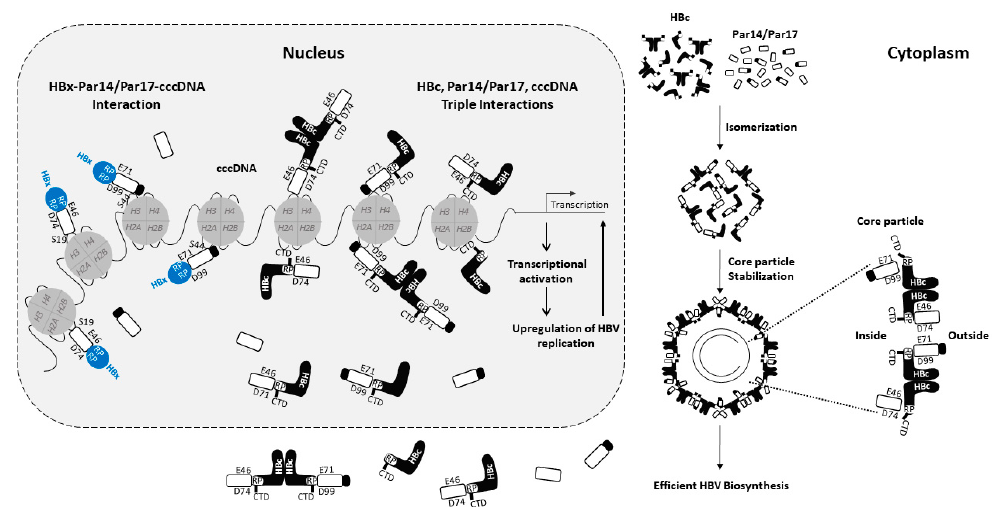
Figure 2. Par14 and Par17 upregulate HBV RNA transcription and DNA synthesis, thereby increasing the HBV cccDNA level. The HBV cccDNA minichromosome is associated with histone and non-histone cellular and viral proteins, including HBc and HBx. The HBx–Par14/Par17–cccDNA complex in the nucleus upregulates HBV RNA transcription, eventually stimulating multiple steps of HBV replication. HBc binds to cccDNA and Par14/Par17 through its C-terminal domain (CTD) and RP motif, respectively. Triple interactions between Par14/Par17, HBc, and cccDNA in the nucleus, and the interaction of Par14/Par17 with core particles in the cytoplasm, upregulate HBV replication. Par14 and Par17 bind directly to HBV cccDNA via their S19 and S44 residues, respectively. The substrate-binding E46 and D74 residues of Par14, and E71 and D99 residues of Par17, are critical for the interactions of these proteins with the RP motifs of HBx, the RP motif of HBc, and core particles. These residues also promote recruitment of HBc and HBx onto cccDNA (modified from [27,28]).